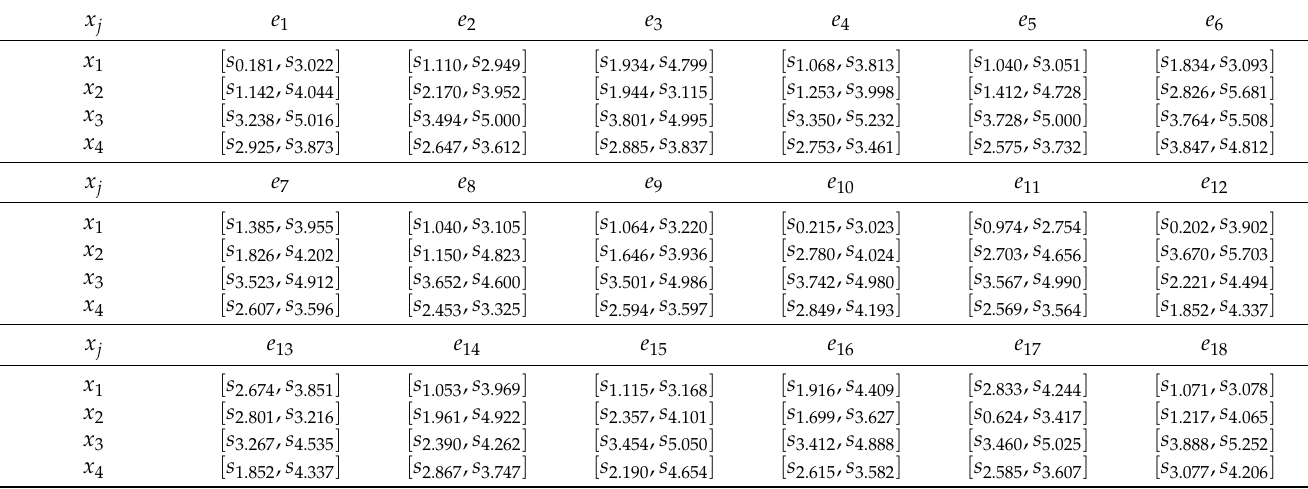
Table 8. The fifth-round decision information of decision makers about